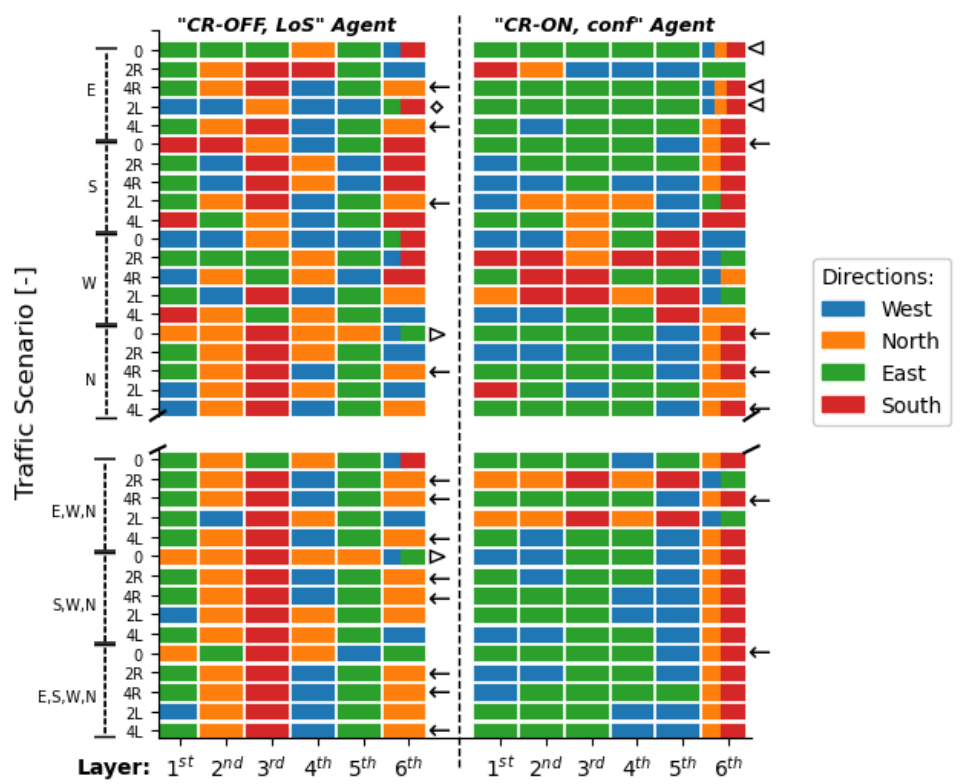
Figure 11. Example of airspace structure output by the two best-performing RL agents. On the left : the RL agent trained without CR, based on the number of LoSs. On the right : the RL agent trained with CR, based on the number of